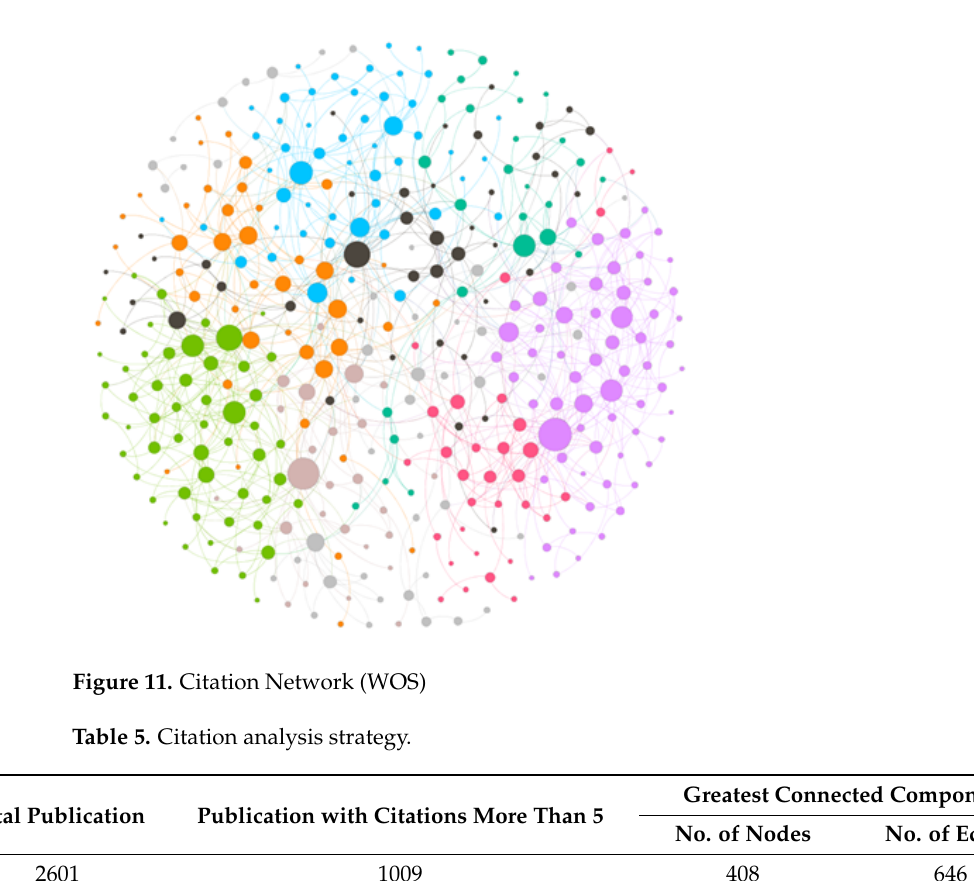
Figure 10. Citation Network (SCOPUS)